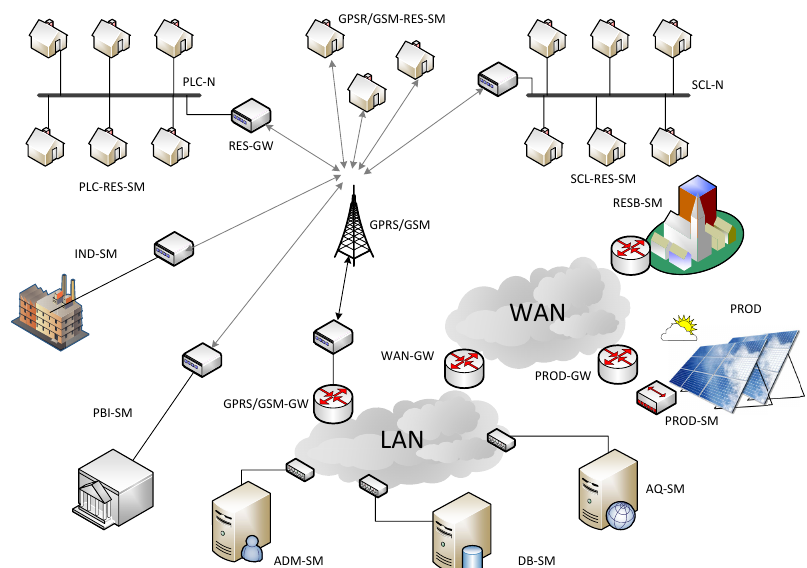
Figure 2. A typical electricity smart metering system structure.